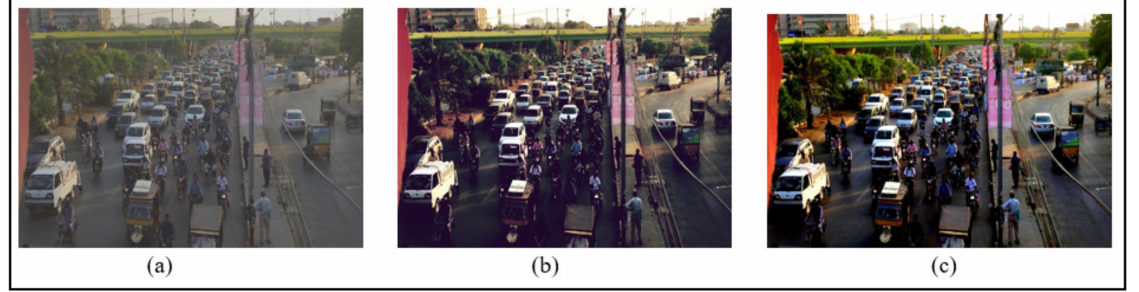
Figure 2. Synthetic image generation using GAN: ( a ) original frame; ( b ) original synthetic image; ( c ) high-resolution